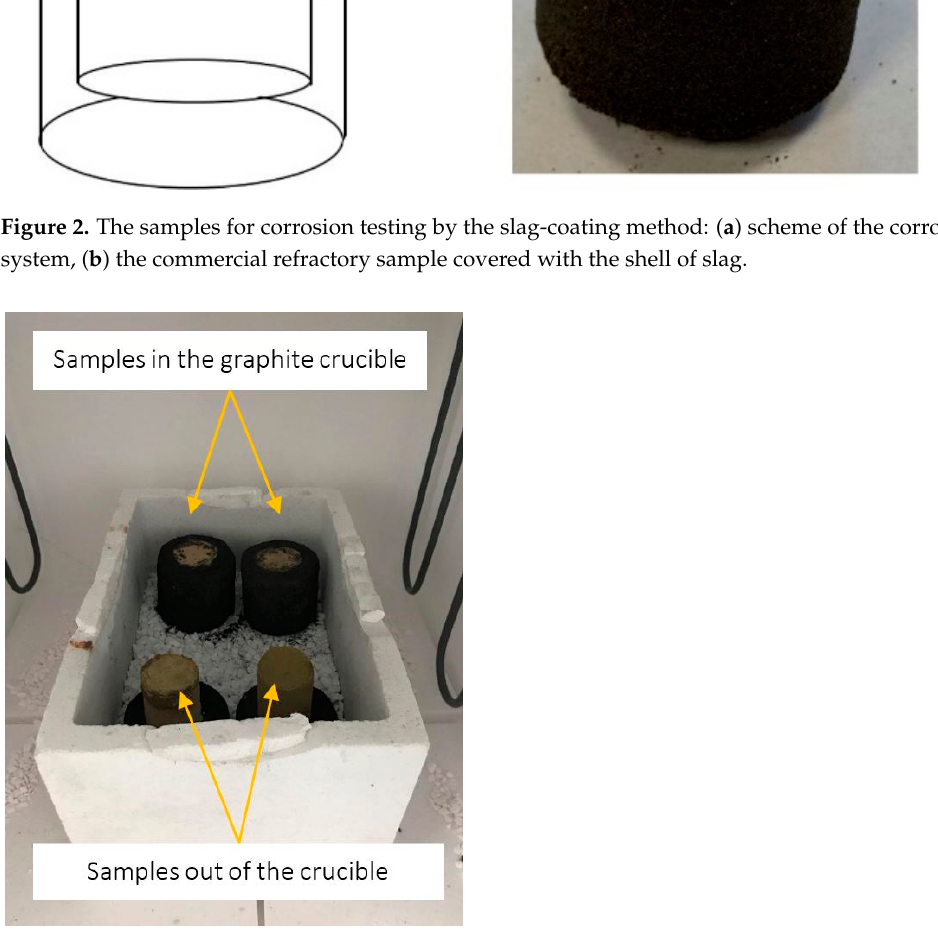
Figure 3. Samples prepared for corrosion testing, presented in two views: in graphite crucibles and out of graphite crucibles. Table 3. Program of corrosion testing.